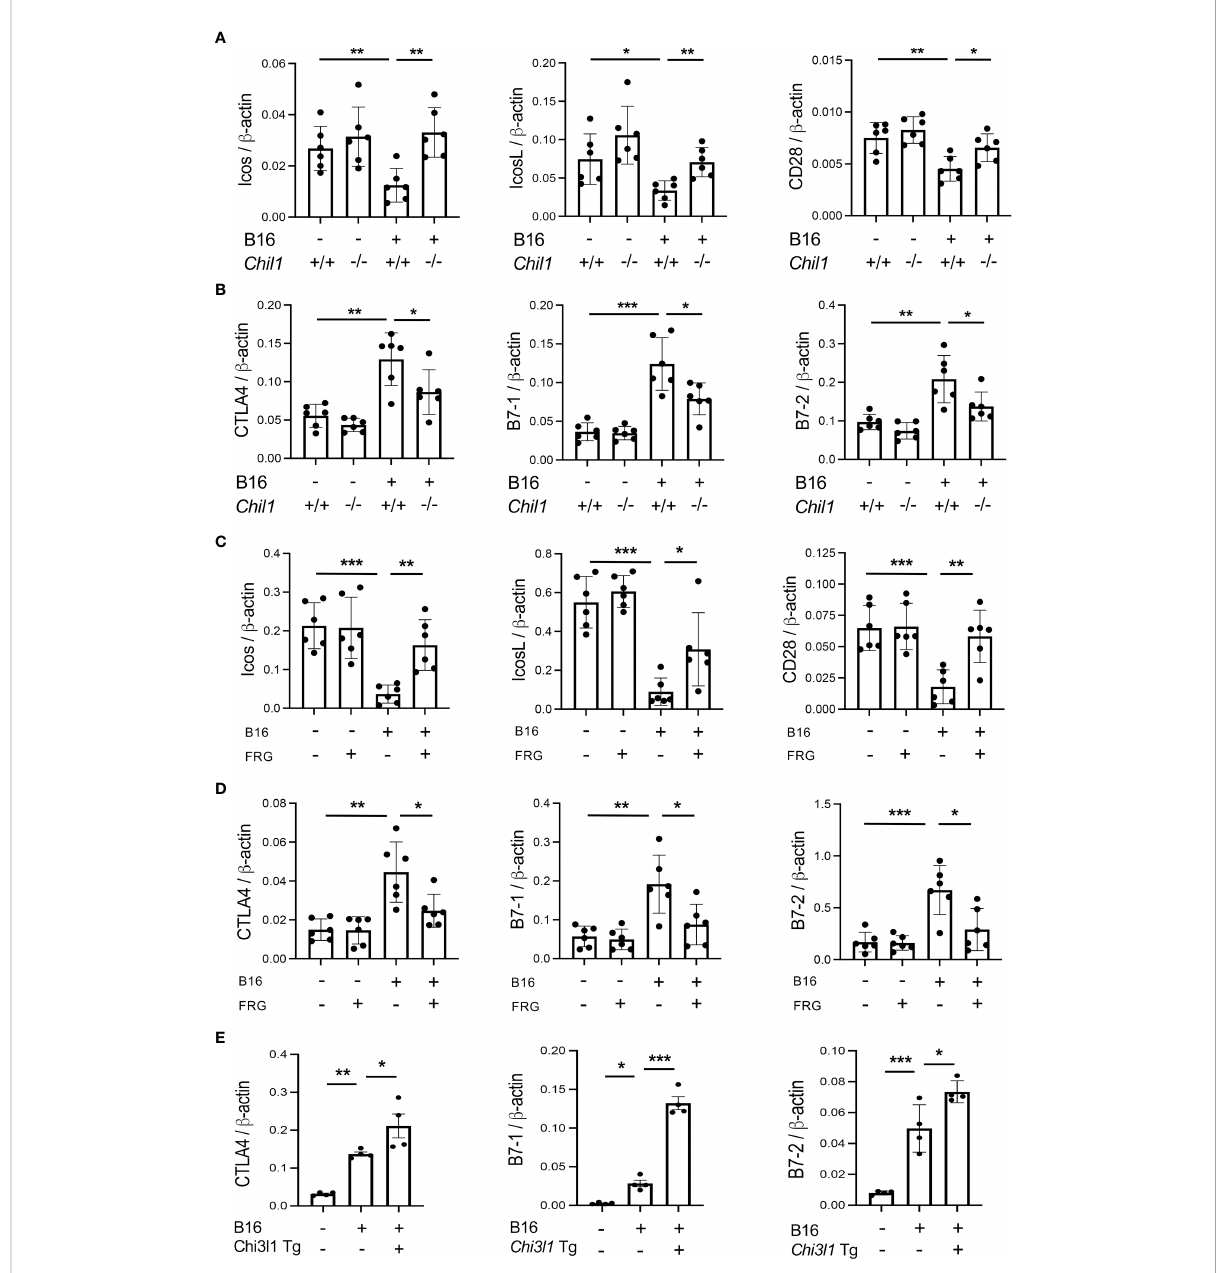
FIGURE 3 CHI3L1 plays a critical role in B16 cell regulation of T cell co-stimulators and the induction of CTLA-4 and its ligands. WT ( Chil1 +/+ ) and Chi3l1 null ( Chil1 -/- ) mice were used to evaluate the expression and accumulation of co-stimulators (ICOS, ICOS L CD28) and CTLA-4, B7-1 and B7-2 in the lung. (A) RT-PCR was used to quantitate the levels of mRNA encoding ICOS, ICOS L and CD28 in the lungs from WT mice and Chil1 -/- mice randomized to receive B16 cells (B16+) or control vehicle (B16-). (B) RT-PCR was used to quantitate the levels of mRNA encoding CTLA-4, B7-1and B7-2 in the lungs from WT mice and Chil1 -/- mice randomized to receive B16 cells (B16+) or control vehicle (B16-). (C, D) RT-PCR was used to quantitate the levels of mRNA encoding ICOS, ICOS L, CD28 CTLA-4, B7-1 and B7-2 in the lungs from WT mice randomized to receive B16 cells (B16+) or vehicle control (B16-) and randomized to receive the FRG antibody (FRG+) or an isotype antibody control (FRG-). (E) RT-PCR was used to quantitate the levels of mRNA encoding CTLA-4, B7-1 and B7-2 in the lungs from WT mice and Chi3l1 transgenic ( Chi3l1 Tg) mice randomized to receive B16 cells (B16+) or vehicle control (B16-). In all panels each dot represents the evaluation in an individual animal. The values in these panels represent the mean±SEM of the noted evaluations represented by the individual dots. * P <0.05. ** P <0,01, *** P <0.005 (ANOVA with multiple